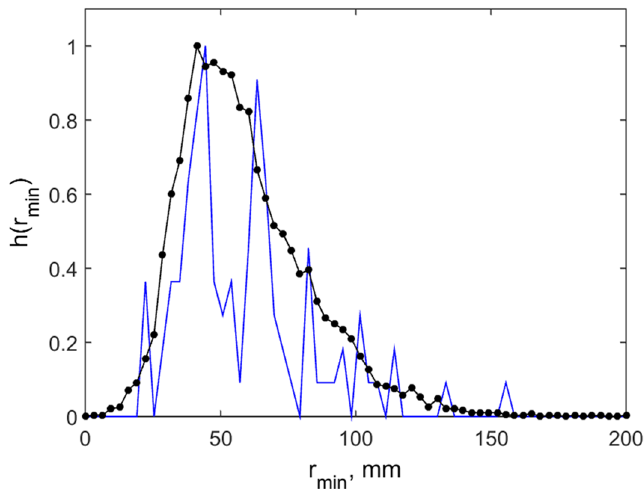
Figure 2. Histograms of the distances between nearest neighbors. Blue line shows some instant distribution. Black line presents histogram accumulated during long run. Maximum of the histogram corresponds to the distance R min close to the equilibrium. Long tail of the black curve corresponds to the presence of some individuals inside the voids.